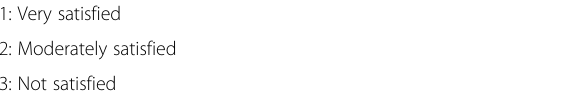
Table 1 Family satisfaction (3-point rating)